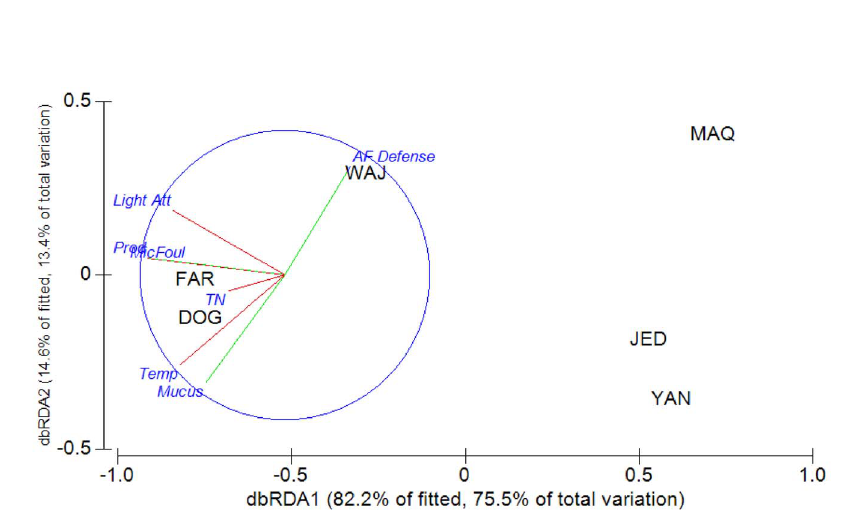
Fig. 5. Anomalies (z-scores) of various biological variables (mucus release, productivity, defense strength) along the Saudi Red Sea coast from north (29 ˚ N) to south (14 ˚ N). R 2 values is the variation explained by the fitted models.